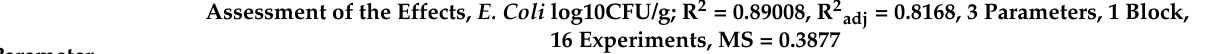
Table 4. Analysis of variance (ANOVA) of inactivation E. coli model with CCD/RSM.